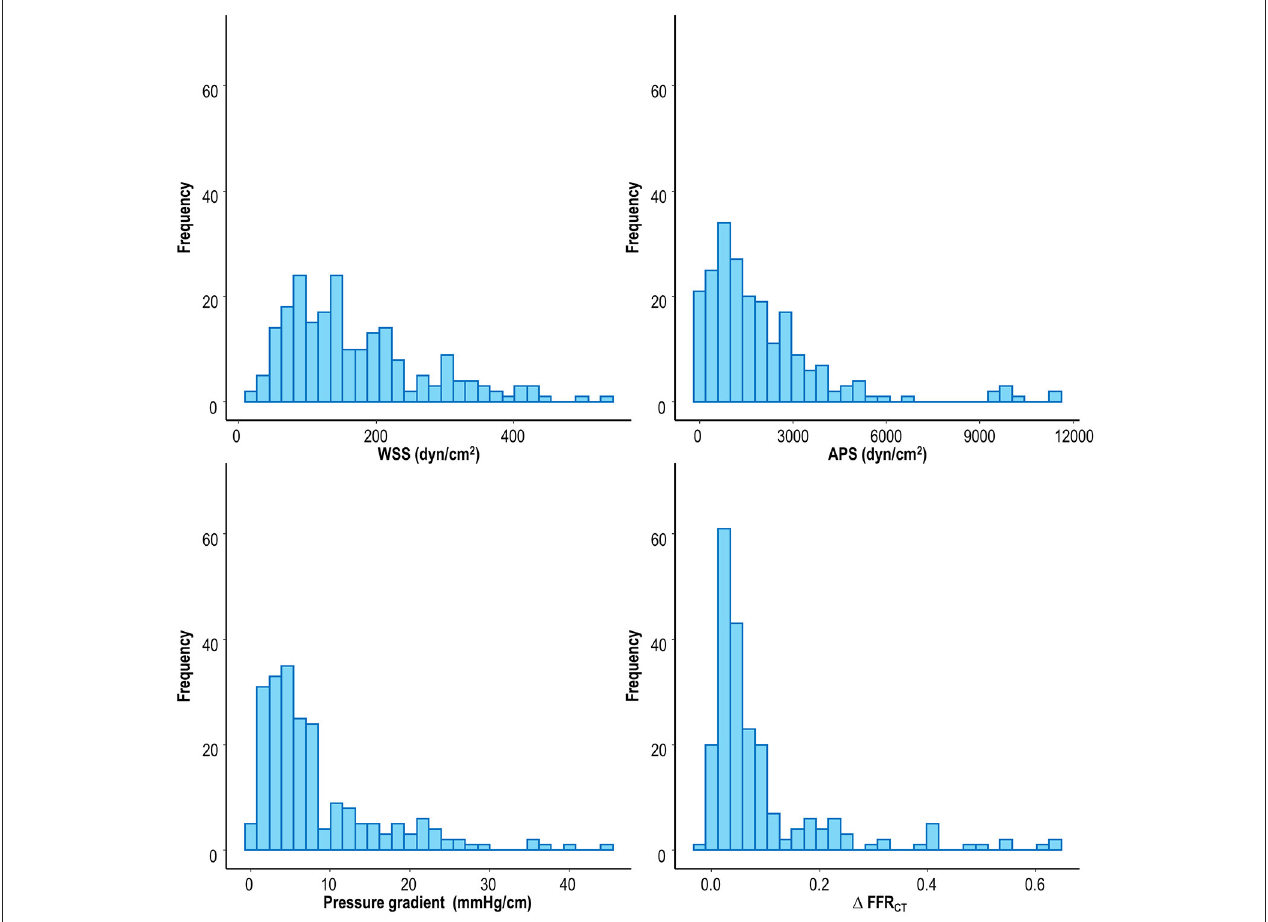
FIGURE 1 | Distribution of local hemodynamic parameters. APS, axial plaque stress; FFR CT , coronary computed tomographic angiography-derived fractional flow reserve; WSS, wall shear stress.